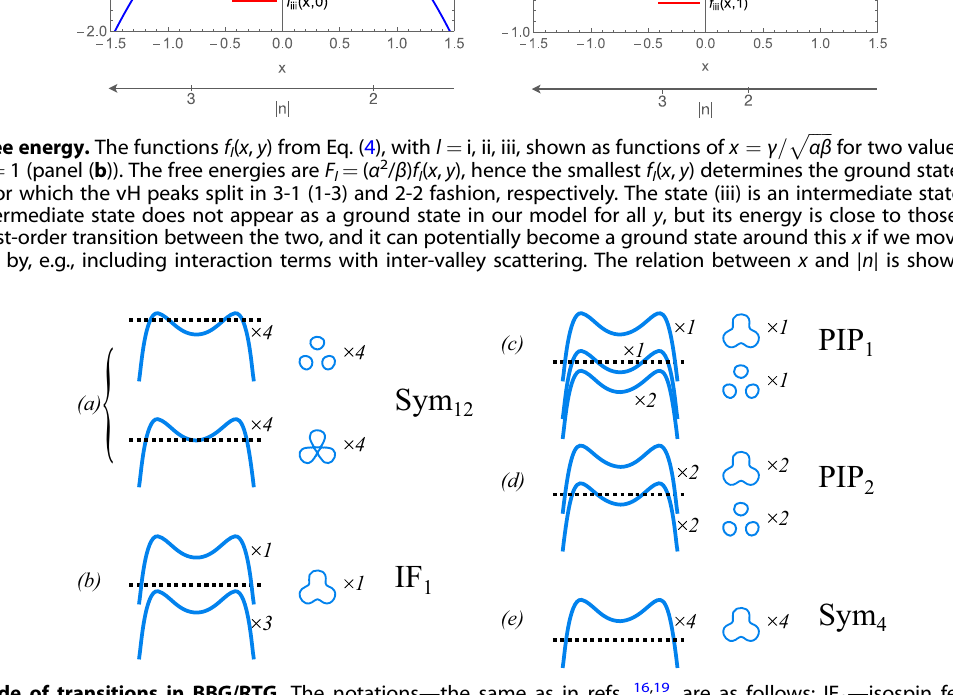
Fig. 3 The cascade of transitions in BBG/RTG. The notations — the same as in refs. 16,19 , are as follows: IF 1 — isospin ferromagnet, PIP 1 — partially isospin-polarized phase with one large Fermi surface and one small, PIP 2 — partially isospin-polarized phase with two large Fermi surfaces and two small, Sym 4 — a symmetric phase with 4 identical large Fermi surfaces (one per isospin), Sym 12 — a symmetric phase with 12 identical small Fermi surfaces (three per isospin). The states in panels a – e are symmetric 4-fold degenerate, 1 – 3, 1 – 1 – 2, 2 – 2, and again symmetric 4-fold degenerate, correspondingly. The 3 − 1 and 2 − 1 − 1 states have not been detected in ref. 16 and are not shown. The small pockets in 1 − 3 (IF 1 ) are assumed to sink below the Fermi level. The symmetry between three small pockets in panels c and d may be broken by subleading interactions, leaving only one small pocket, as the data in ref. 16 indicate.